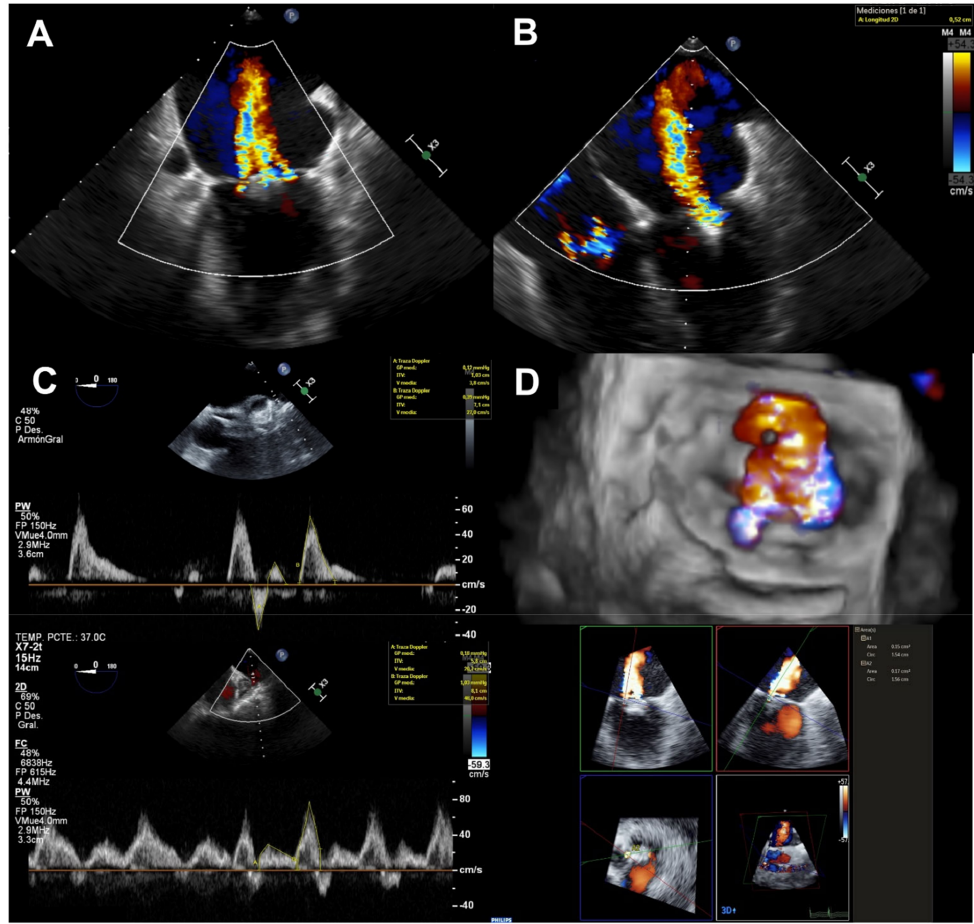
Figure 2. Multiparametric TEE evaluation of residual MR after MitraClip deployment. Significant residual MR assessment with the different quantitative parameters: number of jets ( A ), maximum VC ( B ), changes in PV flow ( C ) and 3D VCA of the different jets ( D ). TEE: transesophageal echocardiogram; MR: mitral regurgitation; VC: vena contracta; PV: pulmonary vein; VCA: vena contracta area.